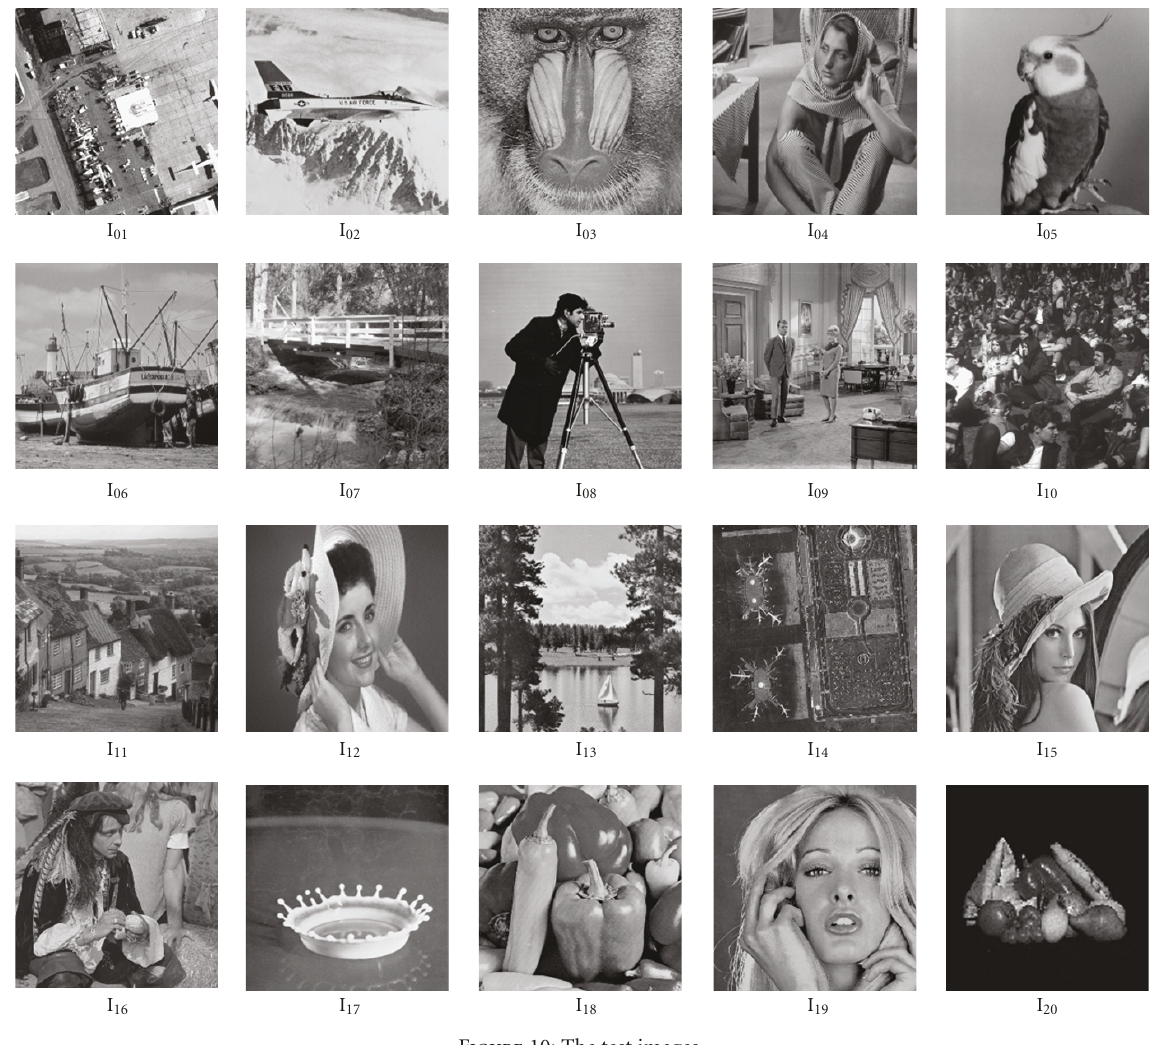
Figure 10: The test images. Table 3: PSNRs obtained by watermarking the images in Figure